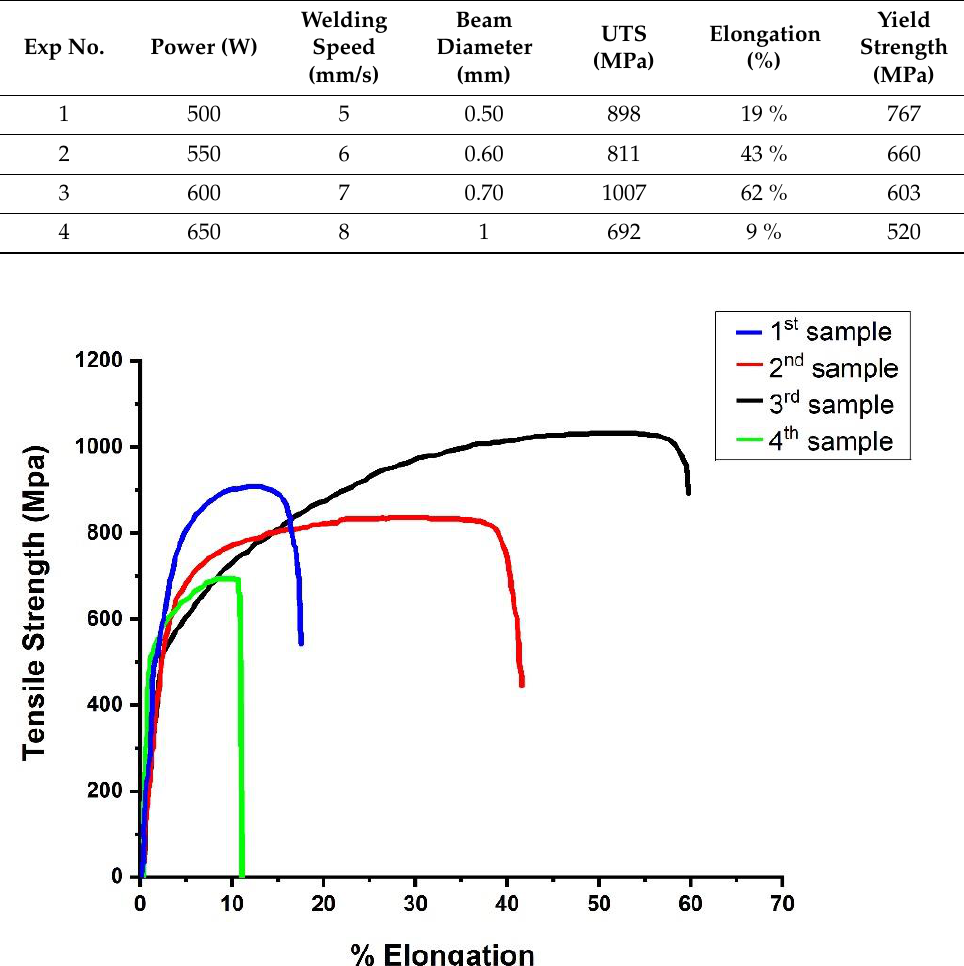
Table 3. Experimental values of mechanical properties for the welded samples with different pro- cess parameters.